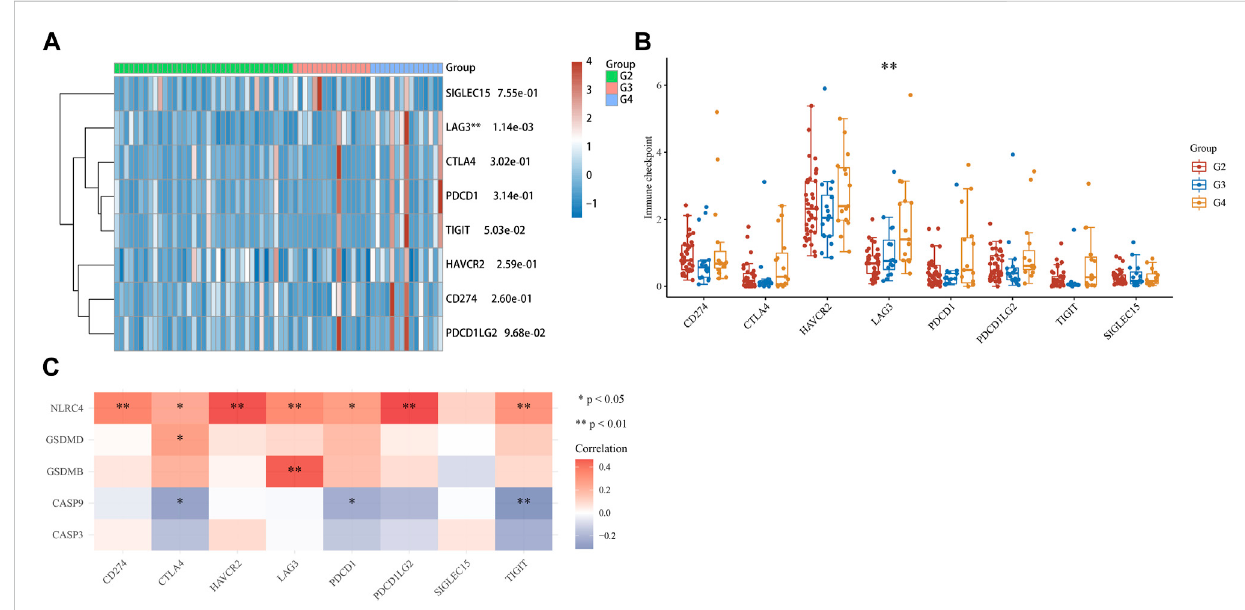
FIGURE 9 Immune checkpoints analysis. (A, B) Different expressions of immune checkpoints in G2, G3, and G4 of ACC. (* p < 0.05, ** p < 0.01, *** p < 0.001, asterisks (*) stand for signi fi cance levels.). (C) The correlation analysis between fi ve prognostic PRGs and immune